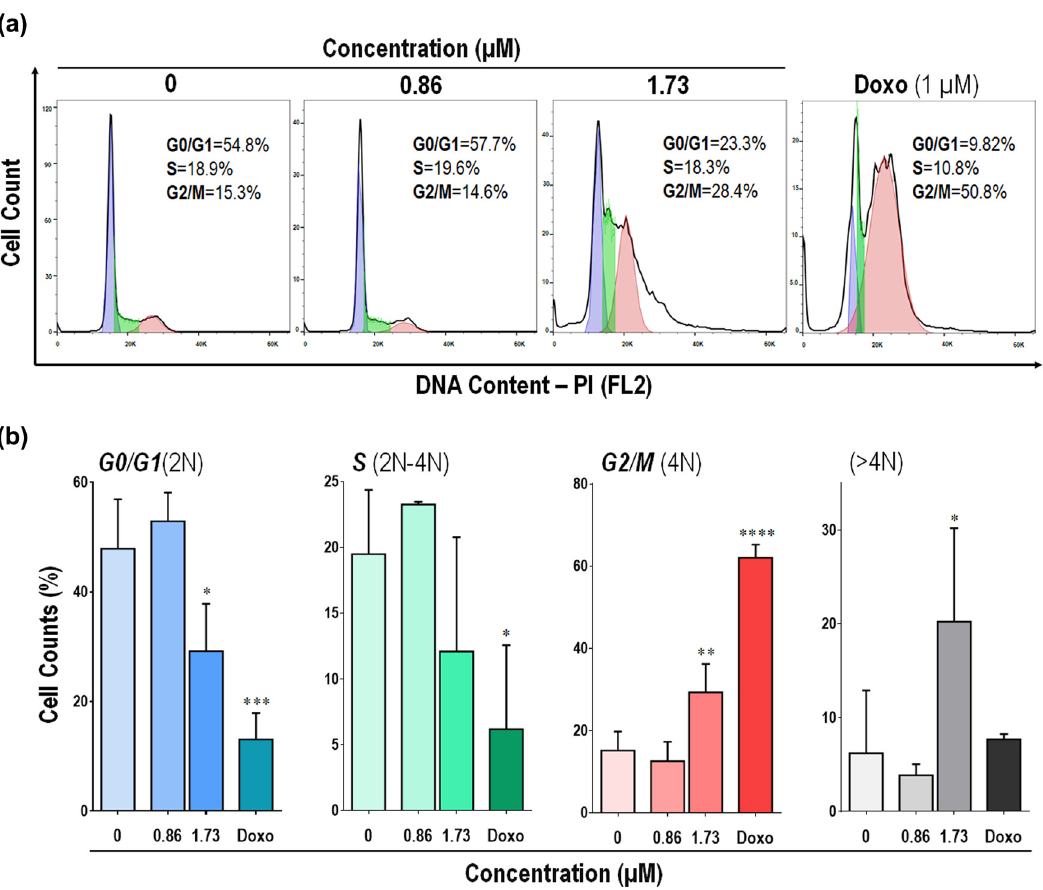
Figure 2: Compound 1 inhibited the proliferation of HT - 29 cells by G2/M - phase arrest. Cell cycle distribution was assessed through staining with PI and fl ow cytometry. ( a ) The histogram shows the number of cells ( vertical axis ) vs DNA content - PI ( horizontal axis - FL2 channel ) . ( b ) Percentage of cells in the indicated cell - cycle phase for the data presented in A. The results are expressed as the mean ± SEM of duplicate samples from three independent experiments ( n = 6 ) . Signi fi cant di ff erences from the control are indicated by * p < 0.05; ** p < 0.01; *** p < 0.001; **** p <